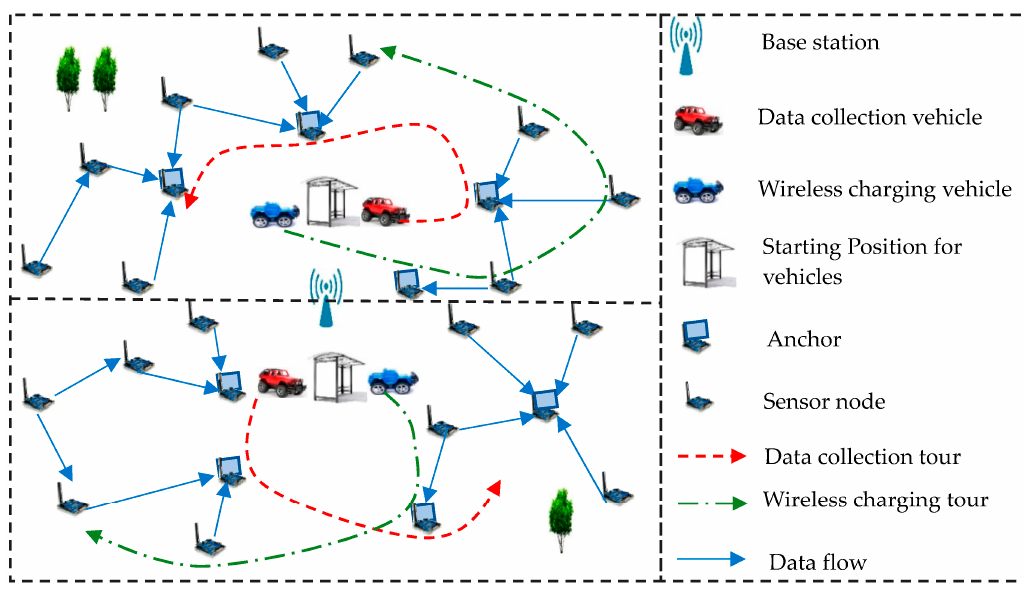
Figure 1. Network model and components.